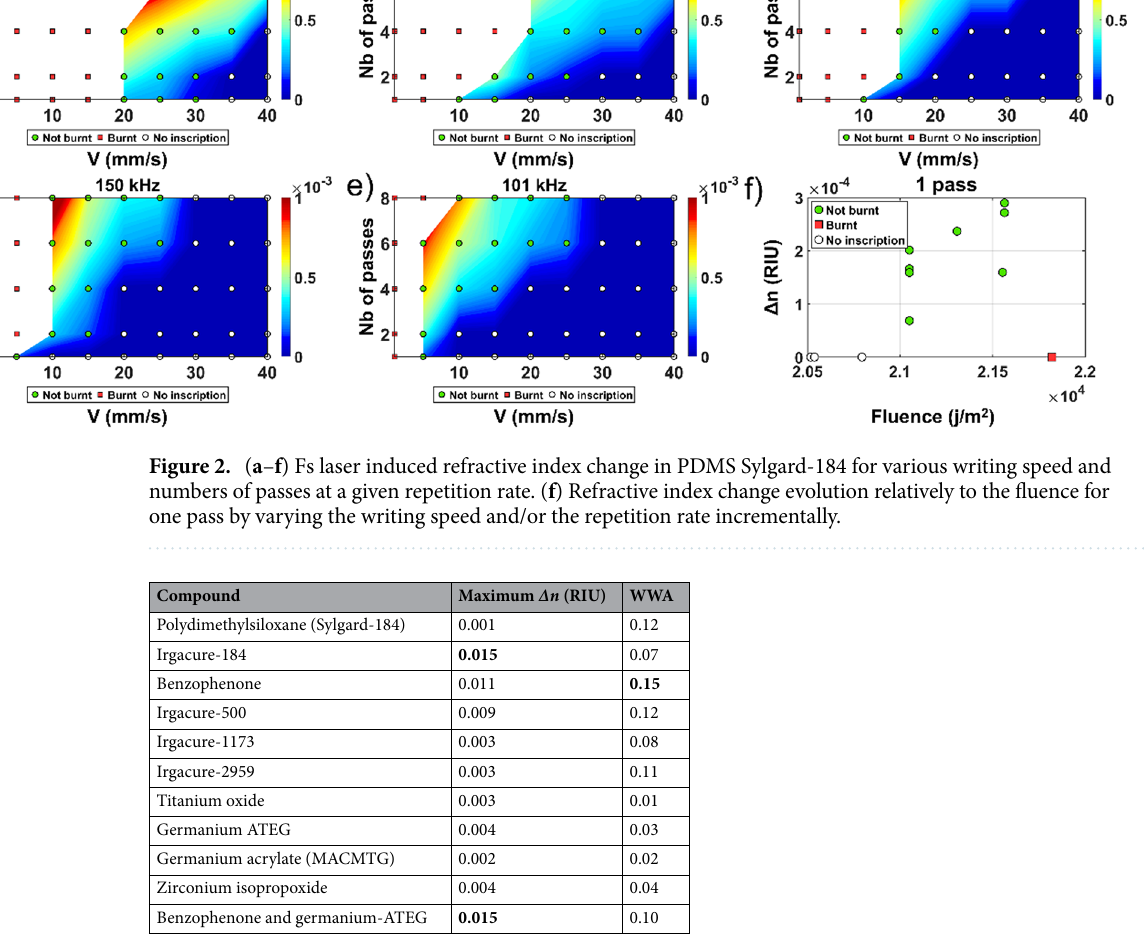
Table 2. Quantitative summary for each photosensitizing agent listing the maximum RI change and the weighted writing area. Significant values are in [bold].